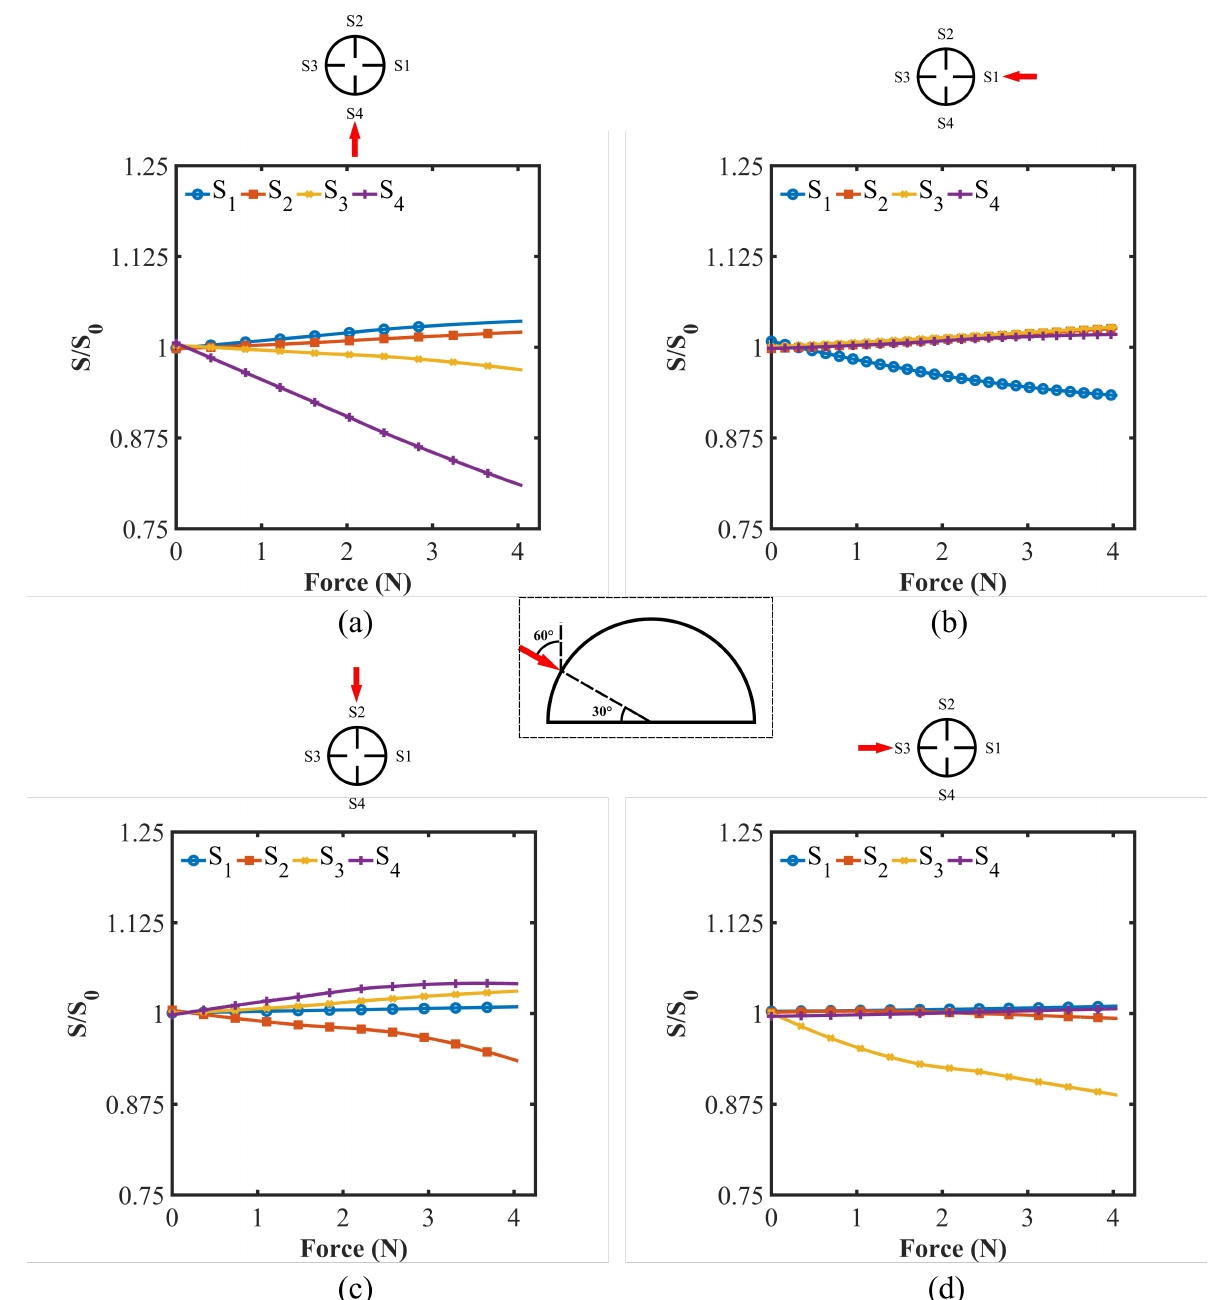
Figure 9. Force calibration against forces along 60 ◦ with vertical axis of the sensor, on the sides of the hemispherical sensor at 30 ◦ latitude (specifically on the ( a ) S 4 , ( b ) S 1 , ( c ) S 2 , and ( d ) S 3 flex sensors); top view of the sensor array is illustrated and the red arrow depicts the applied force